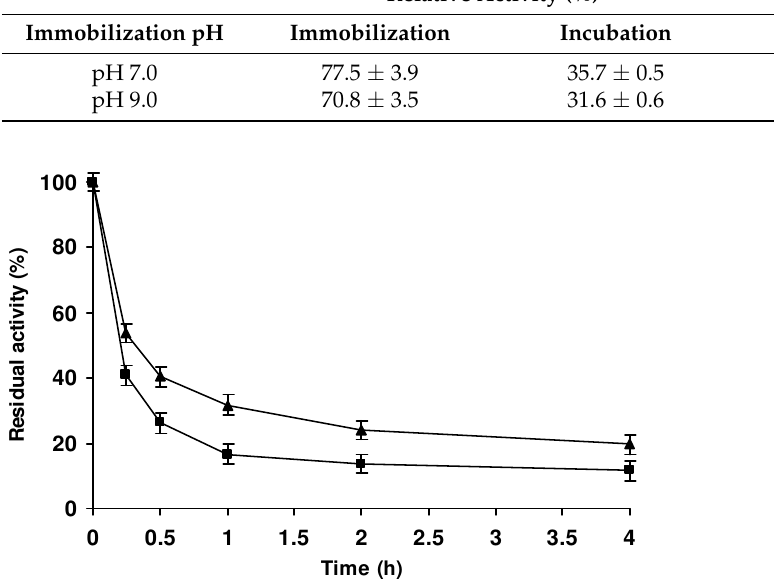
Figure 4. Thermal inactivation courses of PGA immobilized in agarose-MANAE-VS using different immobilization pH values (see legend of Table 2). Full triangles: immobilization in 5 mM of sodium phosphate at pH 7.0. Full squares: immobilization in 5 mM of sodium carbonate at pH 9.0. Other specifications are described in the Methods Section.